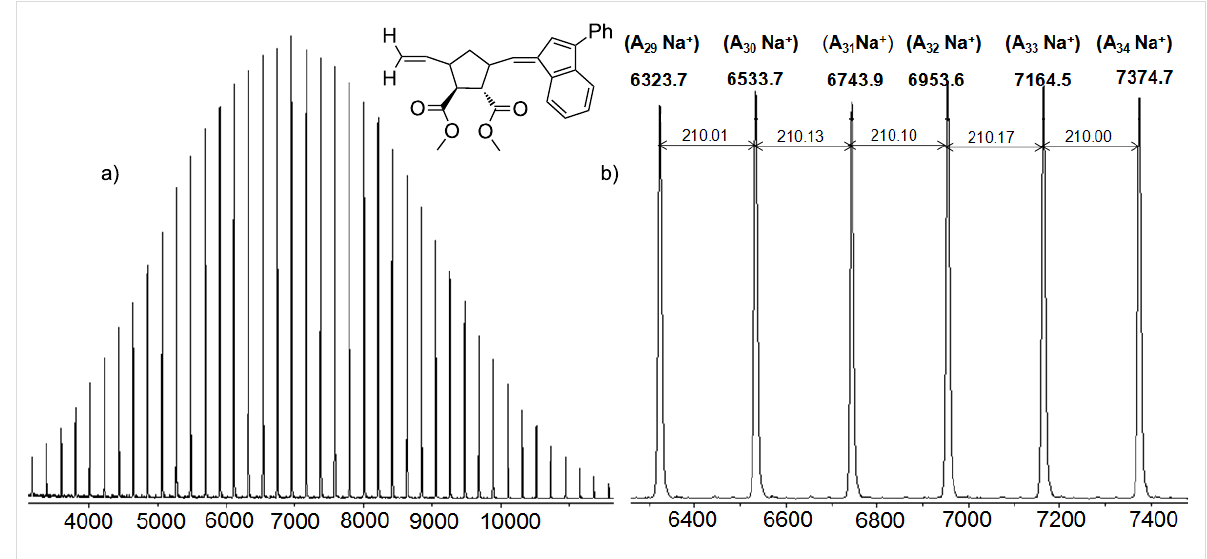
Figure 8: MALDI-TOF mass spectra of homopolymer A 25 4 synthesized with catalyst U3 : (a) full spectrum, (b) expansion.